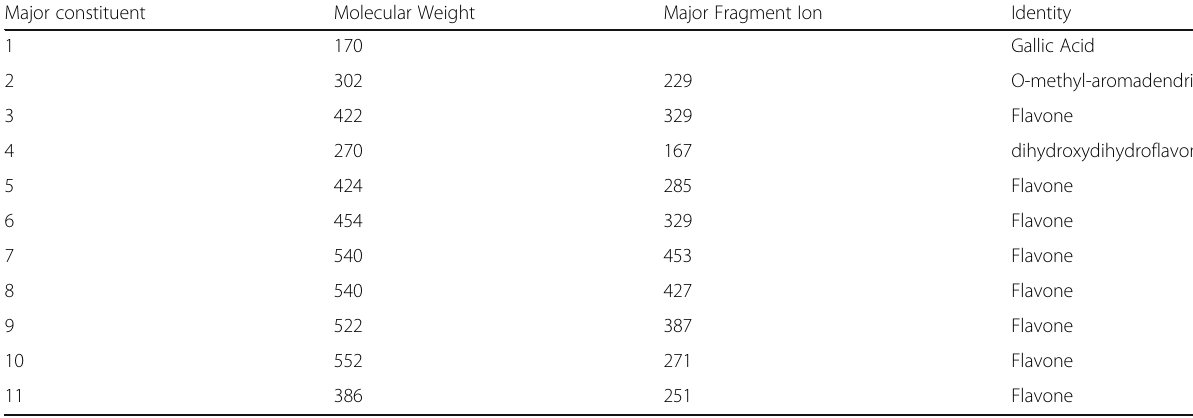
Table 1 Major constituents in the methanol-water extract of T. carbonaria cerumen as determined by HPLC-MS and spectral comparison to known compounds